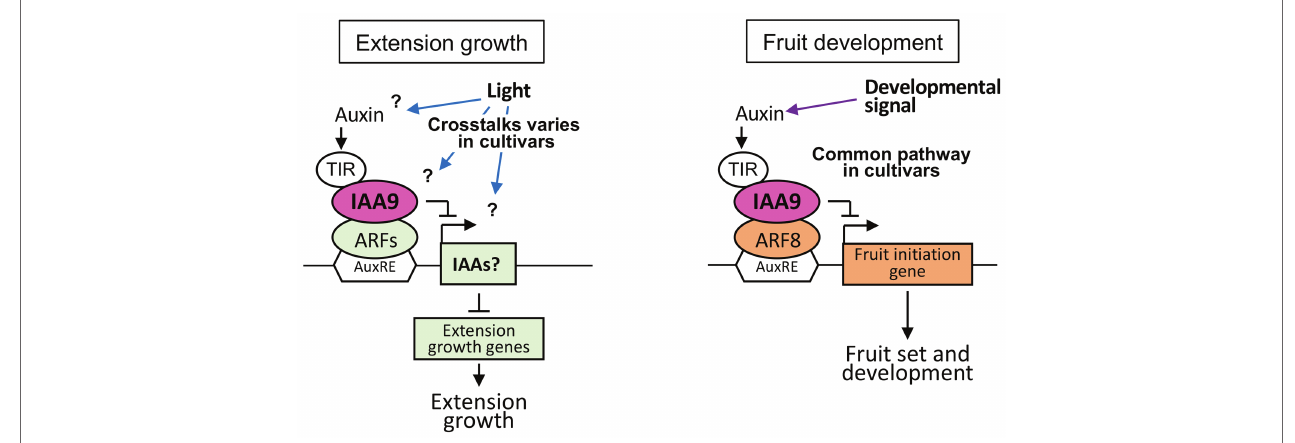
FIGURE 5 | Control mechanisms of elongation growth and fruit development mediated by SlIAA9 in various tomato cultivars. (Left) A hypothetical model of shoot elongation controlled by SlIAA9 in tomato cultivars, Moneymaker, Rio Grande, and Ailsa Craig. (Right) A model of fruit development commonly controlled by SlIAA9 in three tomato